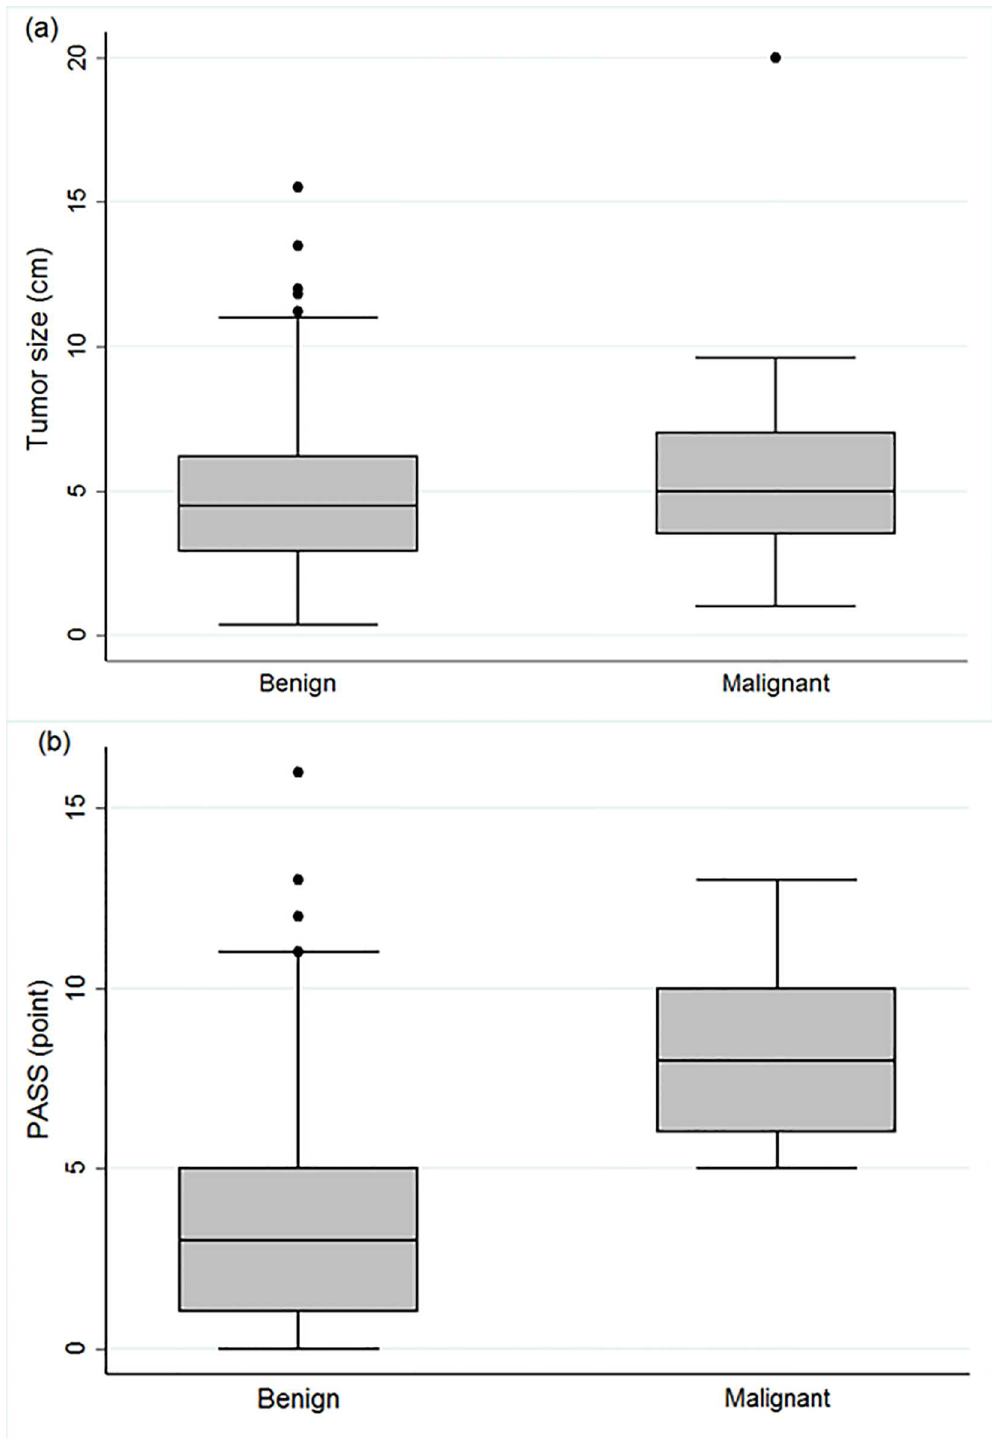
Fig 1. Distributionof (a) tumor size and (b) PASS in patients with benignand malignantPPGLs.